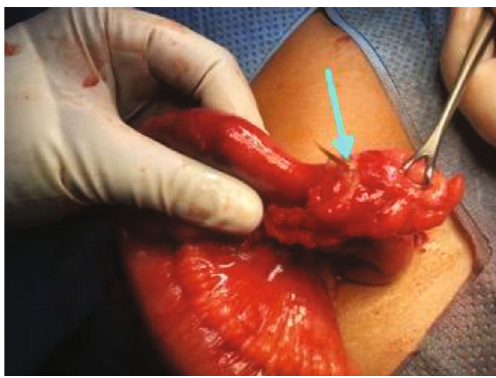
Figure 5: Foreign body seen perforating Meckel ’ s diverticulum in case 5